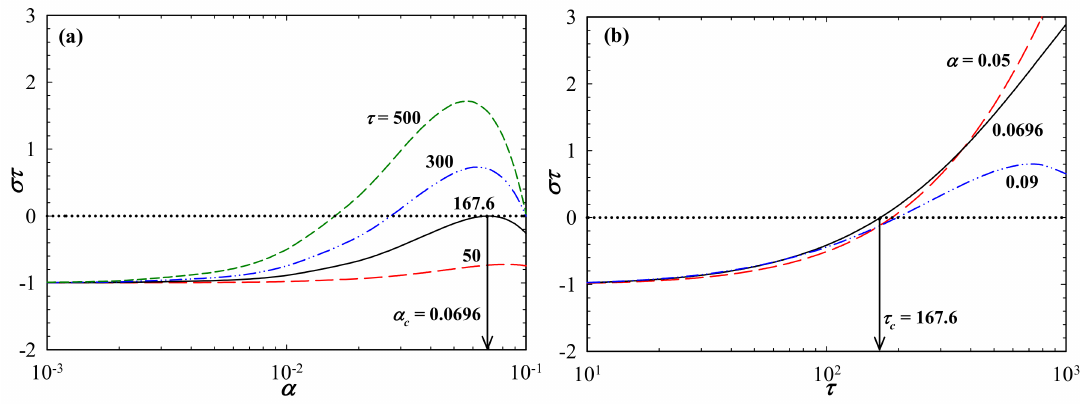
Figure 2. Growth rates versus ( a ) dimensionless wavenumber and ( b ) dimensionless time for a system in the absence of capillary pressure zone, i.e., Bo → ∞ . The other parameters are fixed: M = 0.1 and G =